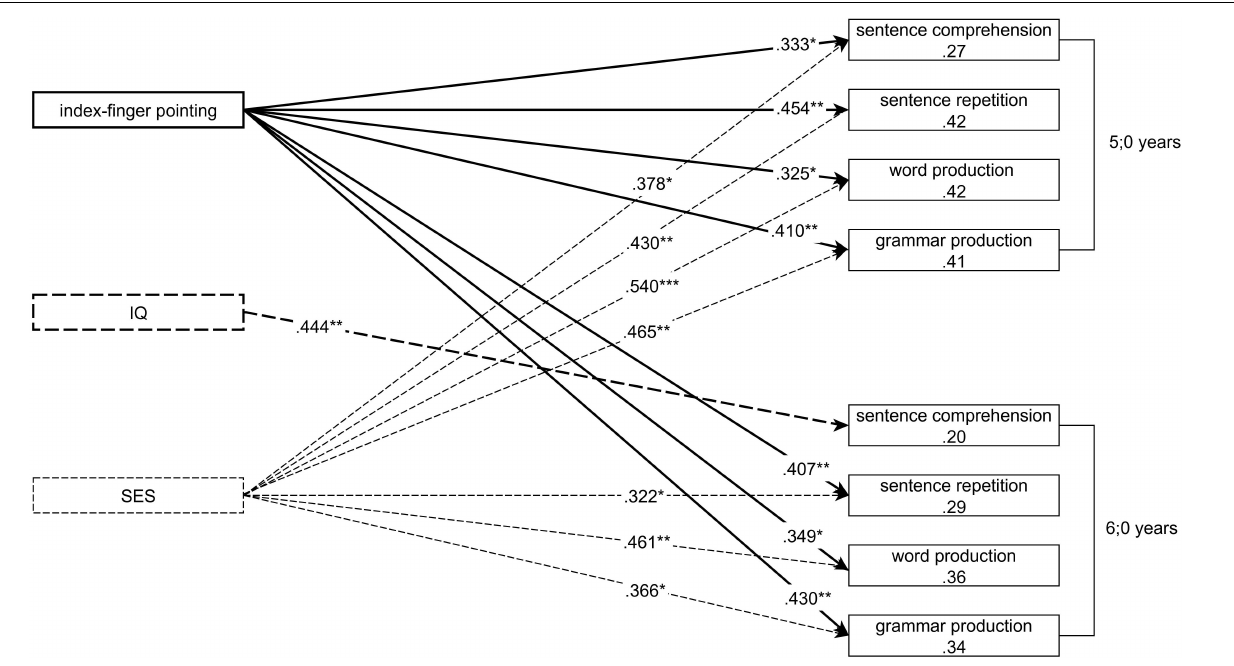
FIGURE 1 | Final models of eight stepwise regression analyses with the independent variables: index-finger pointing at 1;0, non-verbal IQ measured at 3;6 and the SES of the family; and the dependent variables: sentence comprehension, sentence repetition, word production and grammar production at 5;0 and 6;0. Predictor variables were included if they could significantly improve the ability of the models to predict the outcome variables. Presented are standardized betas of the predictor variables and the R 2 of the final models, * p < 0.05, ** p < 0.01, *** p < 0.001. Detailed statistics are presented in the online Supplementary Materials